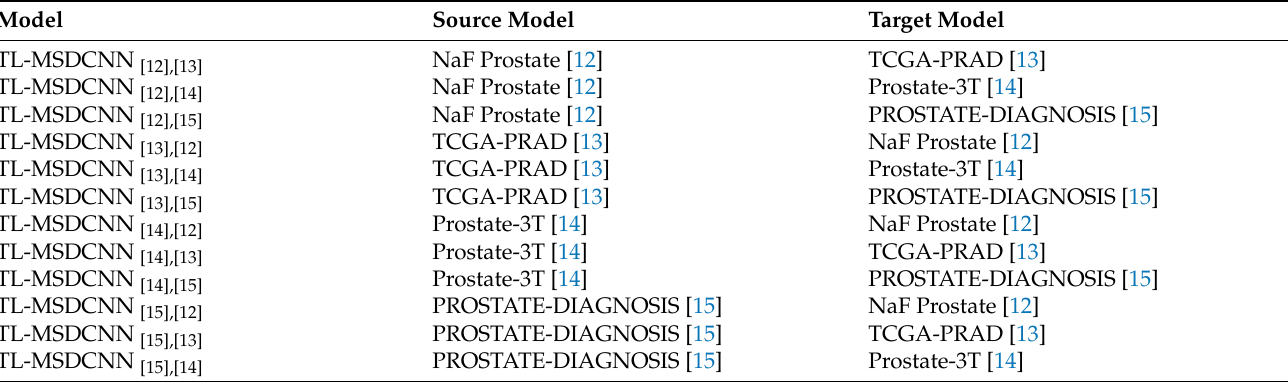
Table 2. Details of the target models.